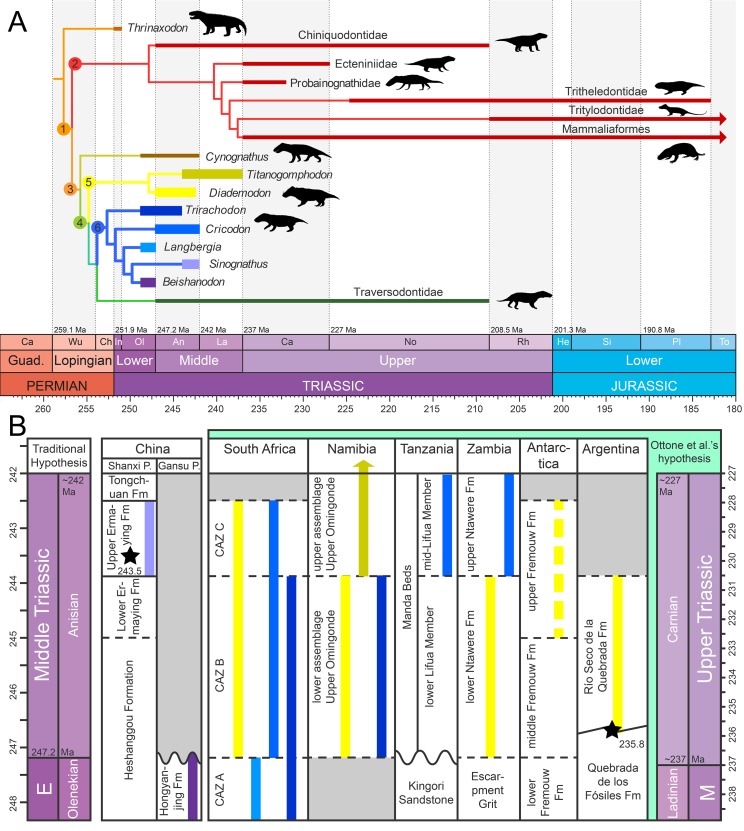
Phylogeny and geographic and stratigraphic distribution of cynodont clades.(A) Tree topology based on the results of the cladistic analyses of Liu & Abdala (2014) for cynognathians and Martínez, Fernández & Alcober (2013) and Martinelli, Soares & Schwanke (2016) for probainognathians. Titanogomphodon, considered to be a close relative of Diademodon by Keyser (1973) and Martinelli, De La Fuente & Abdala (2009), is placed among Diademodontidae. Node 1, Eucynodontia; Node 2, Probainognathia; Node 3, Cynognathia; Node 4, Gomphodontia; Node 5, Diademodontidae; and Node 6, Trirachodontidae. Arrows indicate that the clades extend beyond the Lower Jurassic. (B) Stratigraphic distribution of Diademodontidae (in yellow) and Trirachodontidae (in blue-purple), with Diademodon in pale yellow, Titanogomphodon in dark yellow, Langbergia in pale blue, Cricodon in blue sky, Trirachodon in dark blue, Sinognathus in light purple and Beishanodon in dark purple. Stratigraphic extension of geological units based on Liu, Ramezani & Li (2018) for the Ermaying Formation, Gao et al. (2010) and Niu et al. (2018) for the Hongyanjing Formation, Rubidge (2005) for the Cynognathus Assemblage Zone, Wynd et al. (2018) for the Manda Beds and the Upper Omingonde, Ntawere and Fremouw formations, and Ottone et al. (2014) for the Río Seco de la Quebrada Formation. Stars denote the U-PB geochronologic ages of 243.53 Ma from Liu, Ramezani & Li (2018) for the upper Ermaying Formation in China, and 235.82 Ma from Ottone et al. (2014) for the Río Seco de la Quebrada Formation in Argentina. Wavy lines indicate unconformities and diagonal lines formational interfingering, whereas dashed lines indicate an unclear relationship to the geologic time scale. Age of the Triassic stage limits based on Cohen et al. (2018). Abbreviations: CAZ, Cynognathus Assemblage Zone; E, Early Triassic; Fm, Formation; M, Middle Triassic; Ma, million years; Pr., Province. Ottone et al.’s (2014) hypothesis refers to the Carnian dating for levels of the Río Seco de la Quebrada Formation. Black silhouettes credit: Sergey Meleshin (Sinognathus), José Eduardo Camargo Martínez (all others), used with permission.